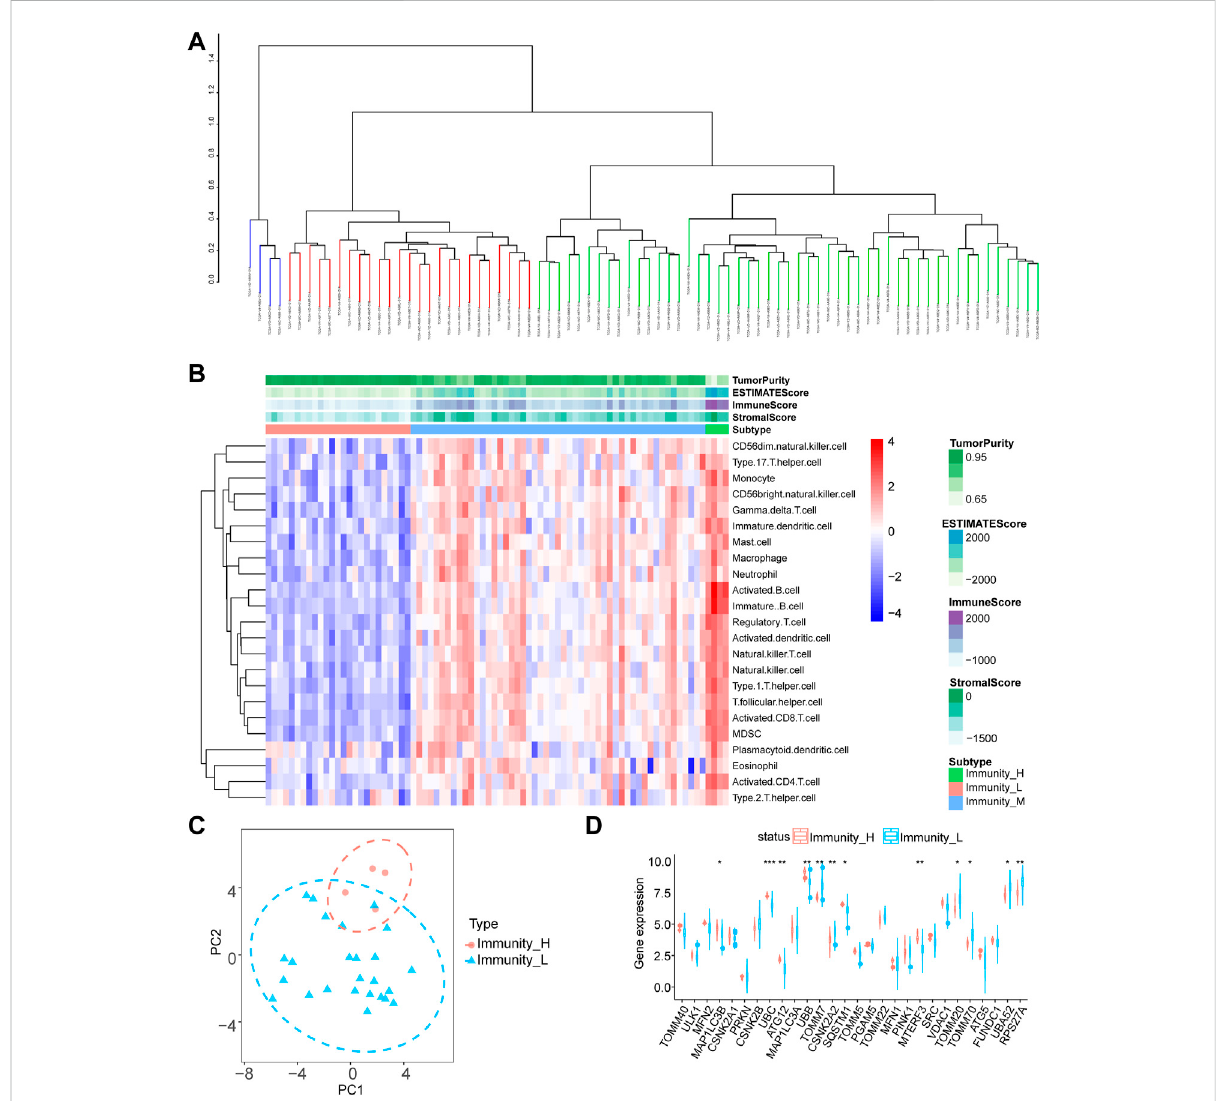
FIGURE 1 Differentialexpressionanalysisofmitophagy-relatedgenes. (A) SsGSEAalgorithmforhierarchicalclusteringoftumorsamplesintheTCGA-UM dataset was divided into three groups: high immune group, medium immune group and low immune group according to the degree of immune in fi ltration. (B) Complexheatmappresentationoftheresultsofimmunein fi ltrationanalysisofimmunesubgroupsoftumorsamplesfromtheTCGA- UM dataset. (C) The PCA analysis results of the high and low immune groups of tumor samples in the TCGA-UM data set are shown. (D) Group comparison graph showing the results of differential expression analysis of mitophagy-related genes between high and low immune subgroups of tumor samplesintheTCGA-UMdataset, red represents thehighimmune group andbluerepresents thelow immune group. Ns,not signi fi cant;* p < 0.05; ** p < 0.01; *** p < 0.001. TCGA, The cancer genome atlas; UM, uveal melanoma; PCA, principal component